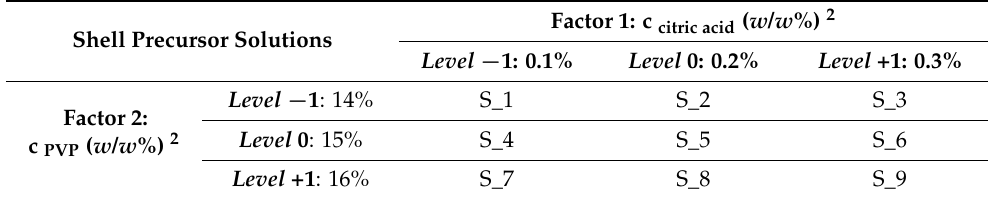
Table 2. Two factorial design table of the composition of precursor solution used for electrospinning experiments, which were then used as a shell precursor solution in the coaxial fiber formation